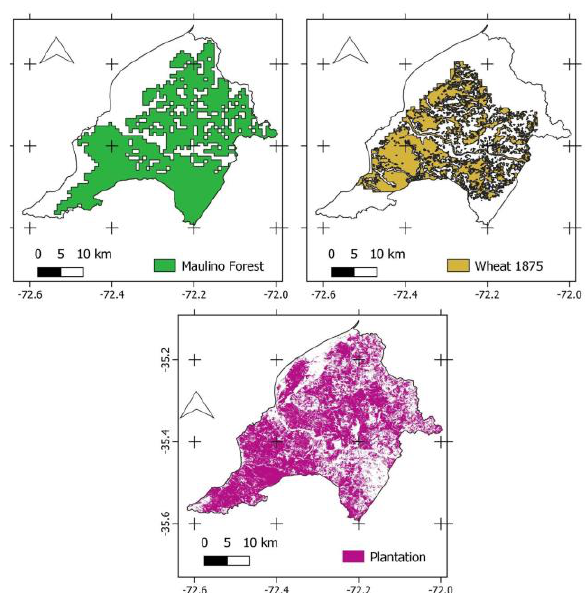
Figure 3 . Maps of the original Maulino forest distribution (upper-left), extent of the wheat production in 1871-1875 (upper-right) and present extent of the forest plantations